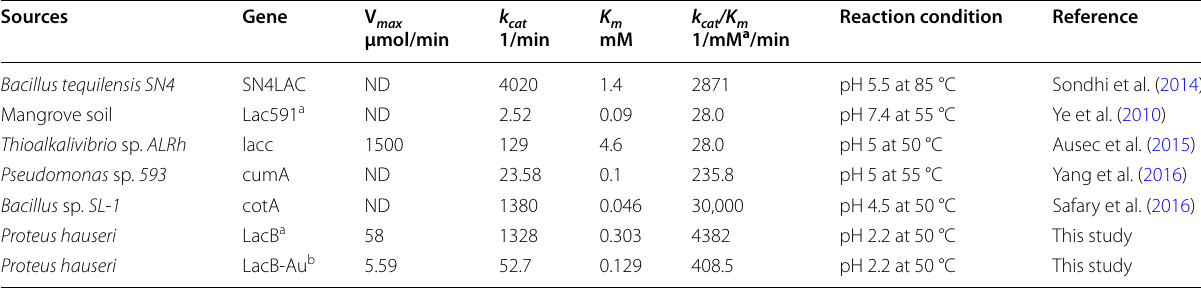
a The yields of LacB of Proteus hauseri and Lac591 of Mangrove soil expressed in E. coli are 1330 and 1381 mg/L, respectively b LacB-Au means with gold binding and followed by activity analysis